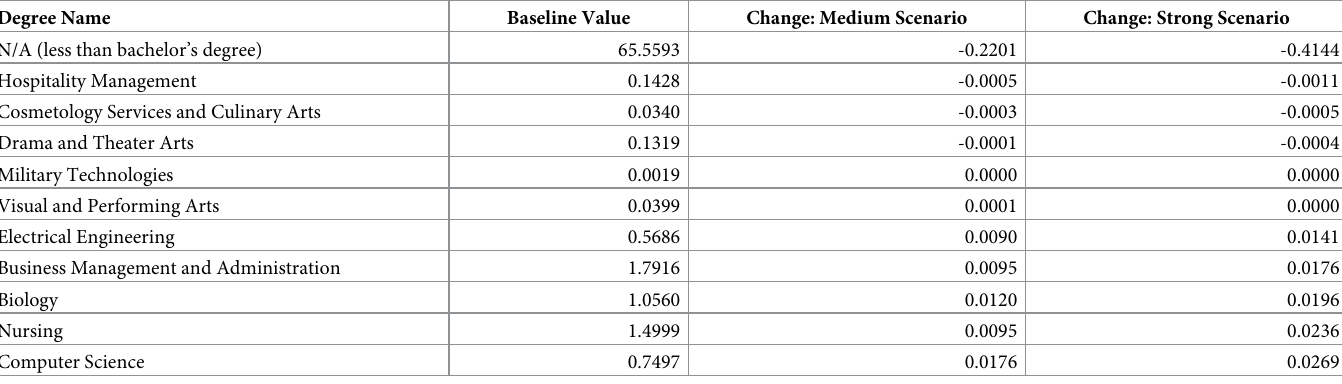
Table 5. Projected changes in percent of workforce holding each degree (shown as a